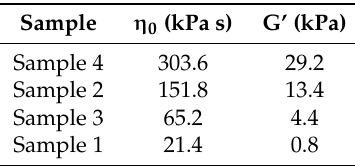
Figure 7. Storage and loss moduli (G’ and G”) of the crosslinked samples with modified talcum (sample 4) and without talcum (sample 2). Table 3. Measured values of the zero viscosity ( η 0) and storage modulus (G‘) at an angular frequency of 0.1 rad/s.